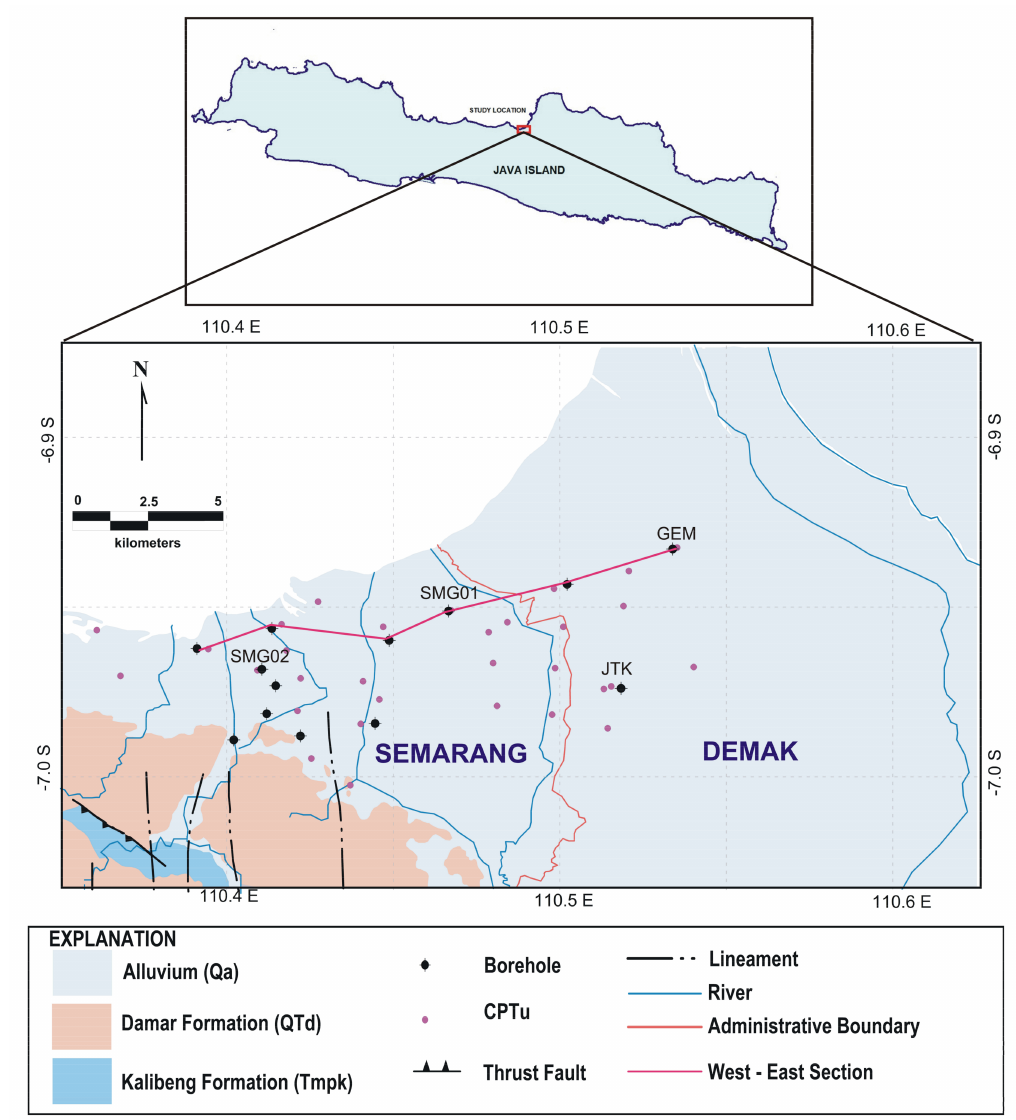
Figure 1. Geology of the study location (modified from